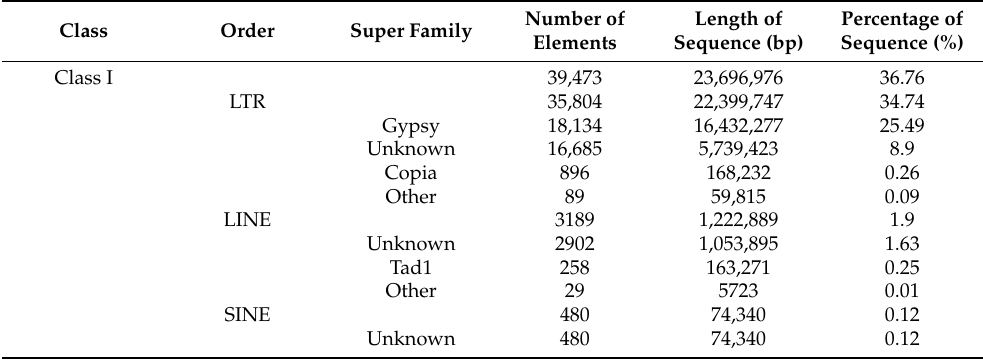
Table 1. Classification of the repeat sequences in the genome of Wolfiporia hoelen